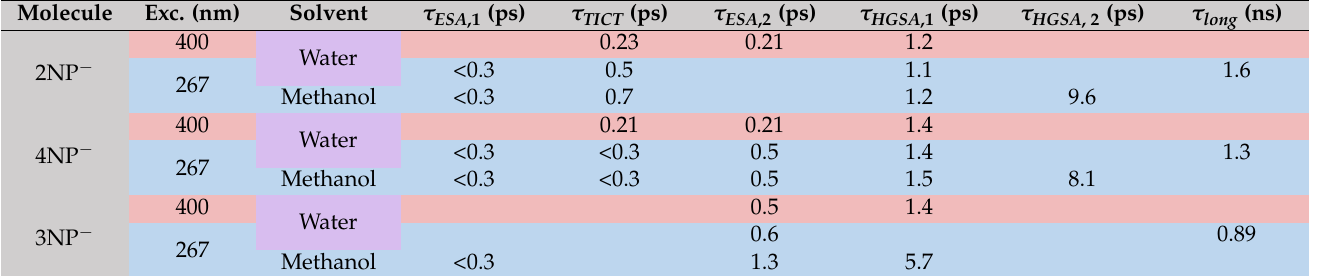
Table 1. Lifetimes and associated states from global analysis of fs-TA spectra of three nitrophenolates in two solvents following excitation at two different wavelengths